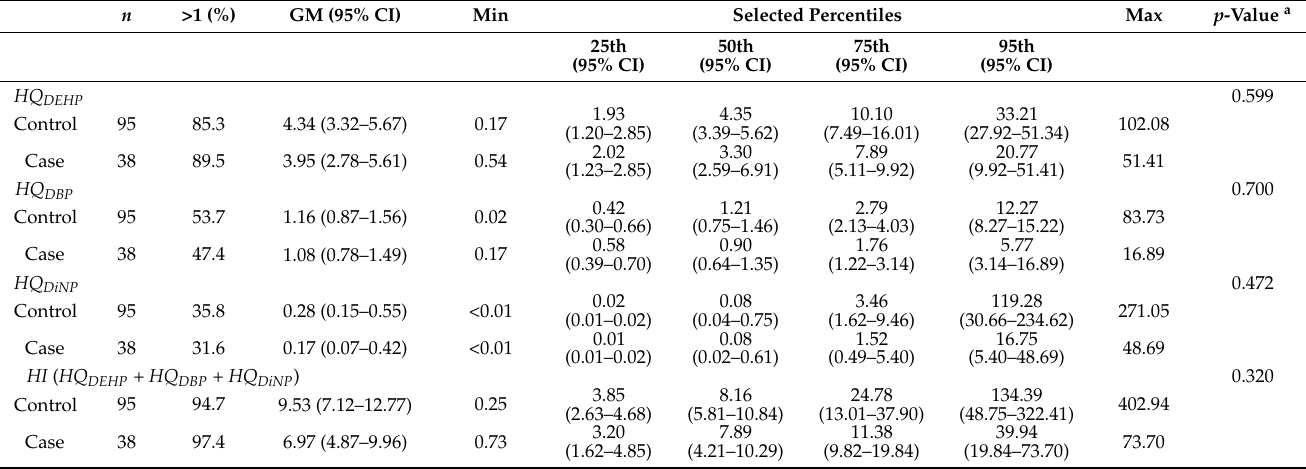
Table 6. Hazard quotients and hazard index by reference dose for control and case groups.